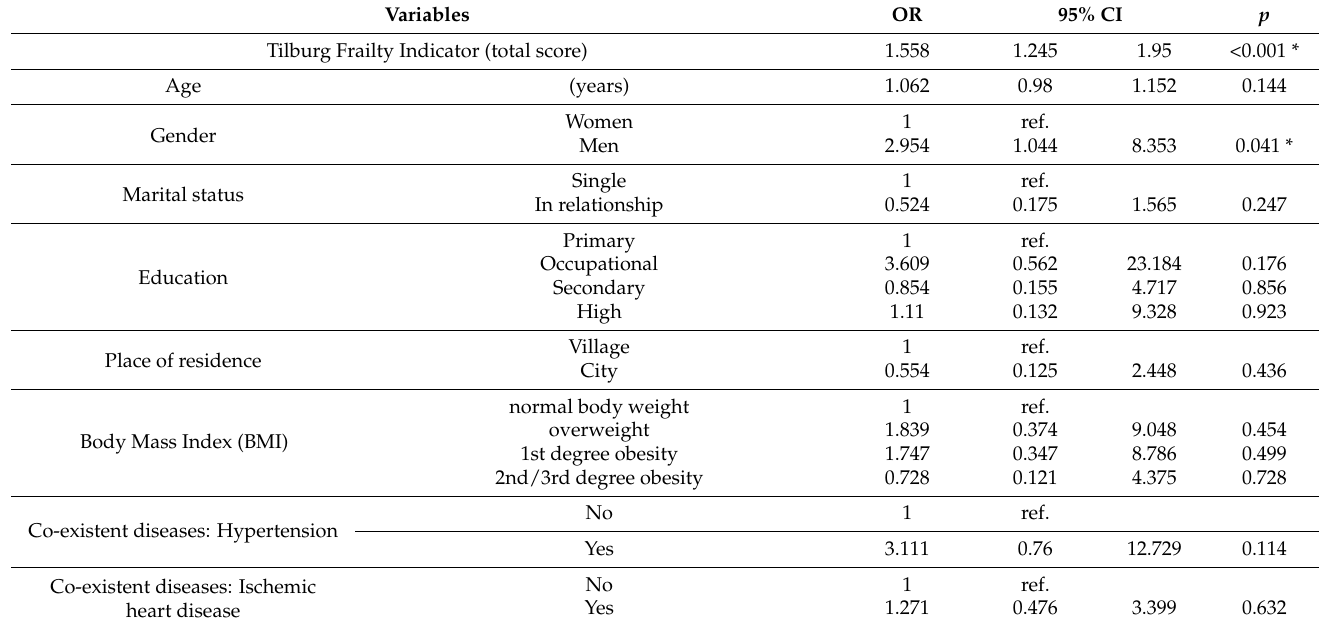
Table 6. Non-adherence predictors-multivariate logistic regression